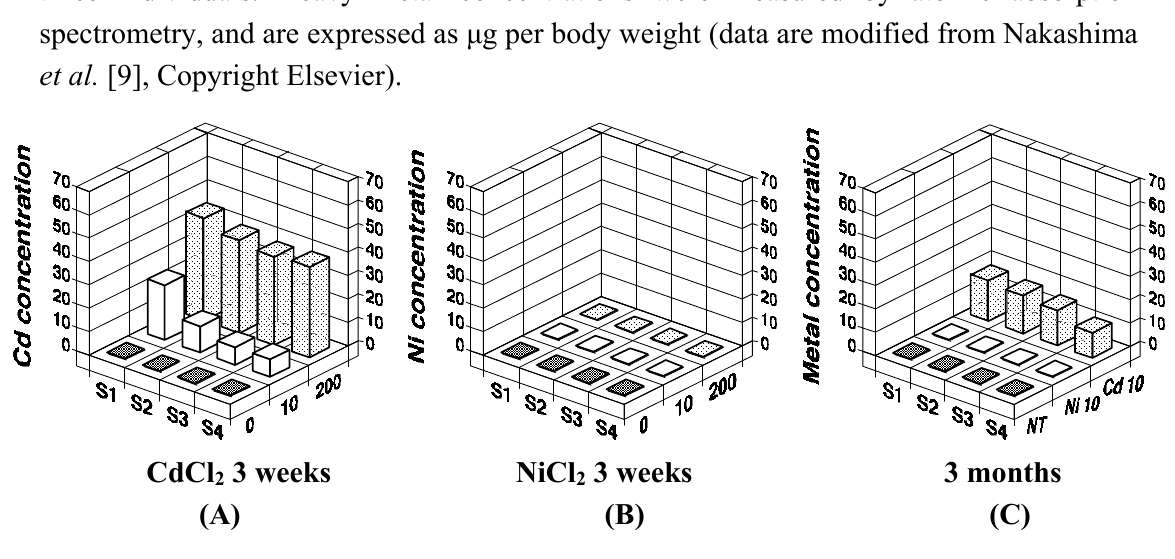
Figure 5. Immunohistochemical analyses of 8-oxo-dG accumulation in alimentary canal (AC) (A) and seminal vesicles (SV) (B) of E. fetida (S1) [data of (B) are modified